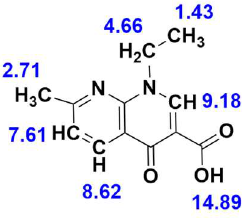
Figure 3. 1 H NMR c hemical shift (δ) values in ppm for nalidixic acid in DMSO- d 6